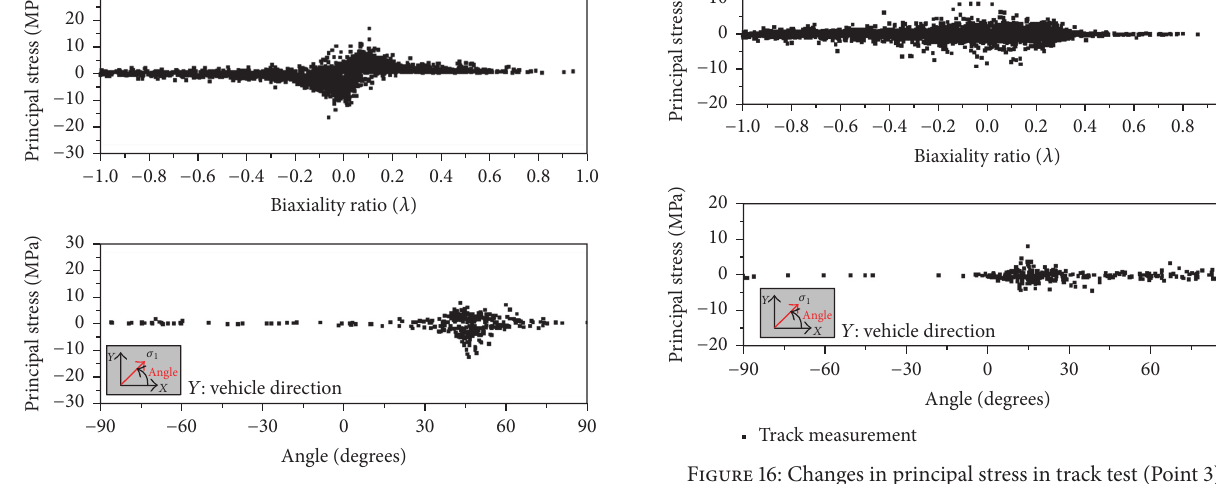
Figure 16: Changes in principal stress in track test (Point 3). used. Under BS7608, the S - N curves are classified according to each class and the nominal stress is applied. In the case of tubular nodal joints, the S - N curve to which the hot-spot stress is applied is given. In addition, according to welding configurations, the fatigue notch factors should be used and it is obtained through stress analysis or measurement. Since the configuration of the bogie frame at the strain gauge point falls under Class F, the S - N curve for the fatigue life evaluation that was used was Class F. When the measurement location is far enough from the welded toe, the measured stresses can be assumed as the nominal stress. When this is not the